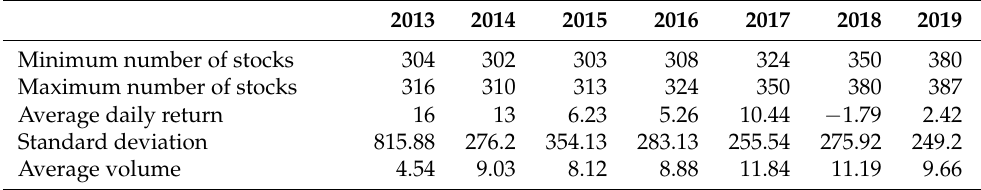
Table 1. Statistical summary of the historical data on the HOSE exchange from 2013 to